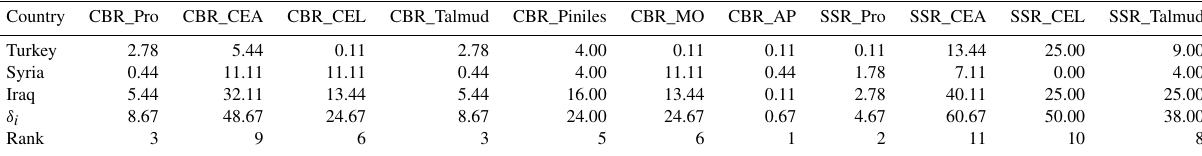
Table 2. The allocated water of The Euphrates River among the riparian countries as a percentage of their water demand (%). Riparian CBR SSR Pro CEA CEL Talmud Piniles MO AP Pro CEA CEL Talmud Turkey 65 85 54 54 70 54 58 62 100 32 50 Syria Iraq